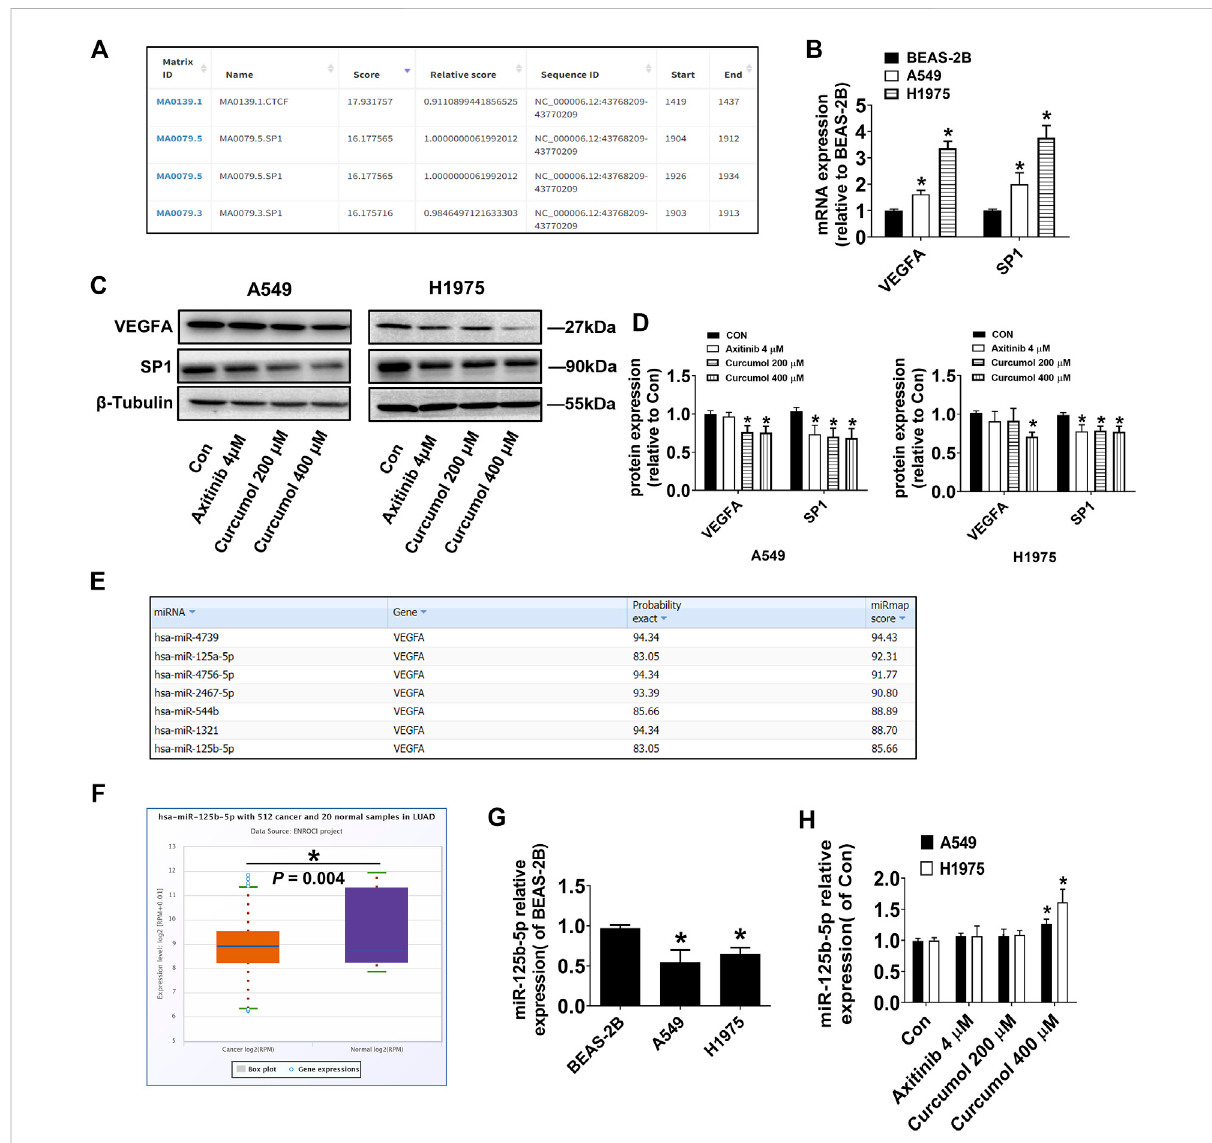
FIGURE 3 Curcumol decreased VEGFA, SP1, but increased miR-125b-5p Expression. (A) Transcription factors in descending order of score, that may regulate VEGFA transcription. (B) mRNA expression level of VEGFA and SP1 in A549 and H1975, relative to that of BEAS-2B. (C , D) VEGFA, SP1 protein expression levels were detected by Western blot. (E) MicroRNAs with more than seven base binding sites at the 3 ′ UTR of VEGFA mRNA searched on miRmap. (F) Differential expression of miR-125b-5p in human normal tissues and tumor tissues. LUAD, Lung Adenocarcinoma. (G) Expression level of miR-125b-5p in A549 and H1975, relative to that of BEAS-2B. (H) Expression level of miR-125b-5p in A549 and H1975, tested by qRT-PCR. The data are presented from fi ve independent experiments (n = 5) run in triplicate. * p < 0.05, compared with control